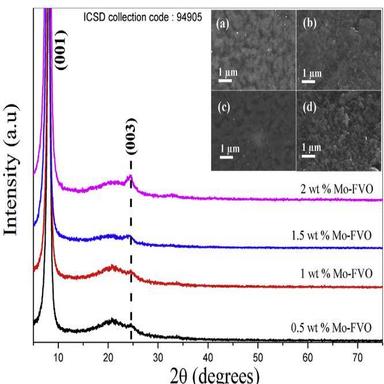
The Comparative XRD patterns of the as deposited Mo-FVO thin films on the Quartz substrates .